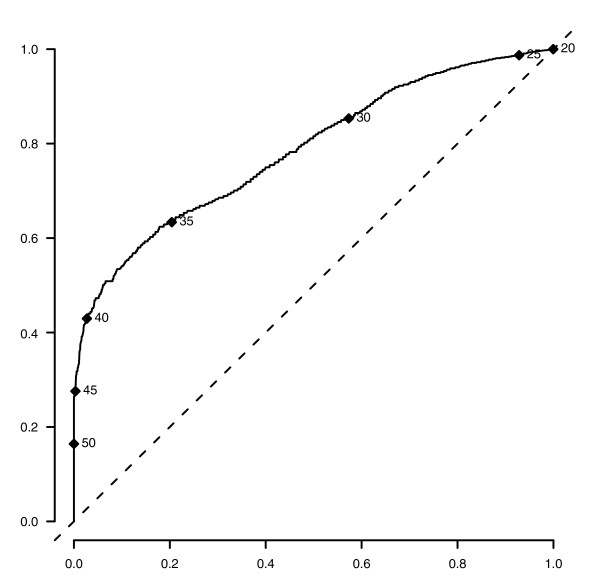
Receiver operator curve for X!Tandem hyperscores. The ROC was used to select the hyperscore cut-off value for candidate peptides. Numbers represent the first instance of the hyperscore values 24, 30, 35, 40, and 45 as they occur among the data points.